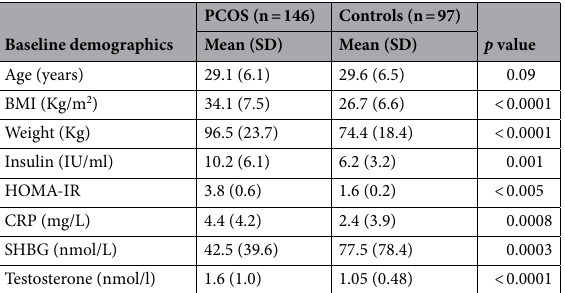
Table 1. Demographics, baseline, hormonal and metabolic parameters of the PCOS subjects and controls. BMI Body mass index, HOMA-IR Homeostasis model of assessment-insulin resistance, CRP C reactive protein, SHBG Sex hormone binding